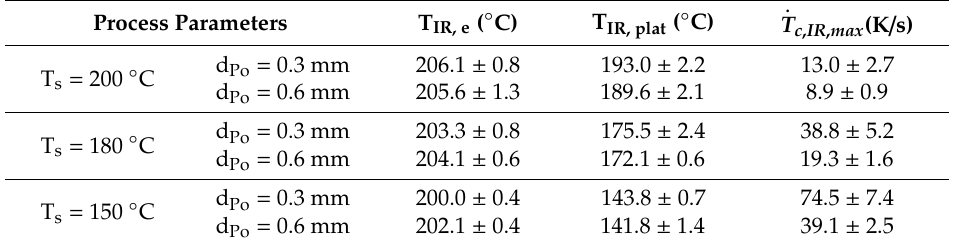
Table 2. Average values for the thermographic determined extrusion, T IR,e , and plateau, T IR,plat , . T c , IR , max , for di ff erent substrate temperatures temperature as well as the maximum cooling rate, (T s = 200, 180, 150 ◦ C) and layer heights (d Po = 0.3, 0.6 mm). . Process Parameters T IR, e ( ◦ C) T IR, plat ( ◦ C) T c , IR , max (K / s) d Po = 0.3 mm 206.1 ± T s = 200 ◦ C d Po = 0.6 mm